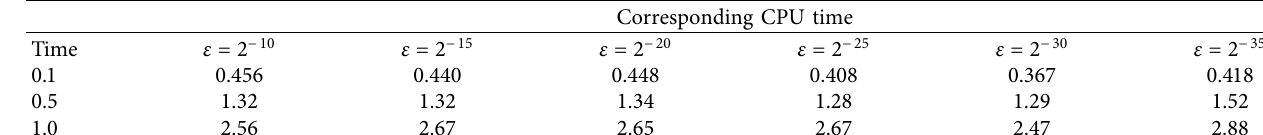
Table 4: CPU time at different time and ε .